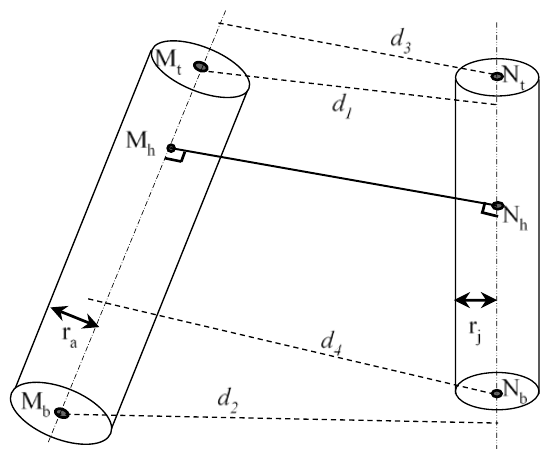
Figure 4. Collison checks between two capsules (two axes are skew).